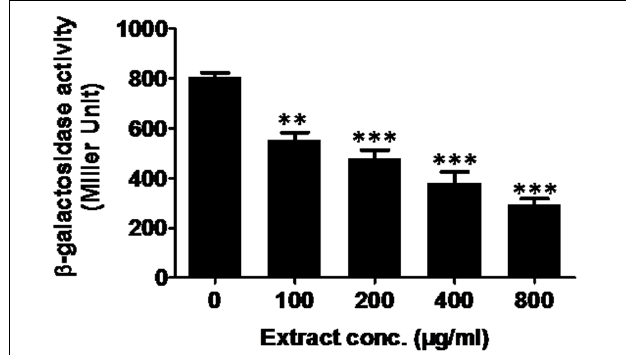
FIGURE 4 | Effect of M. indica (methanol) extract on β -galactosidase activity in E. coli MG4/pKDT17. All of the data are presented as mean ± SD. ∗∗ p ≤ 0.01, ∗∗∗ p ≤ 0.001.